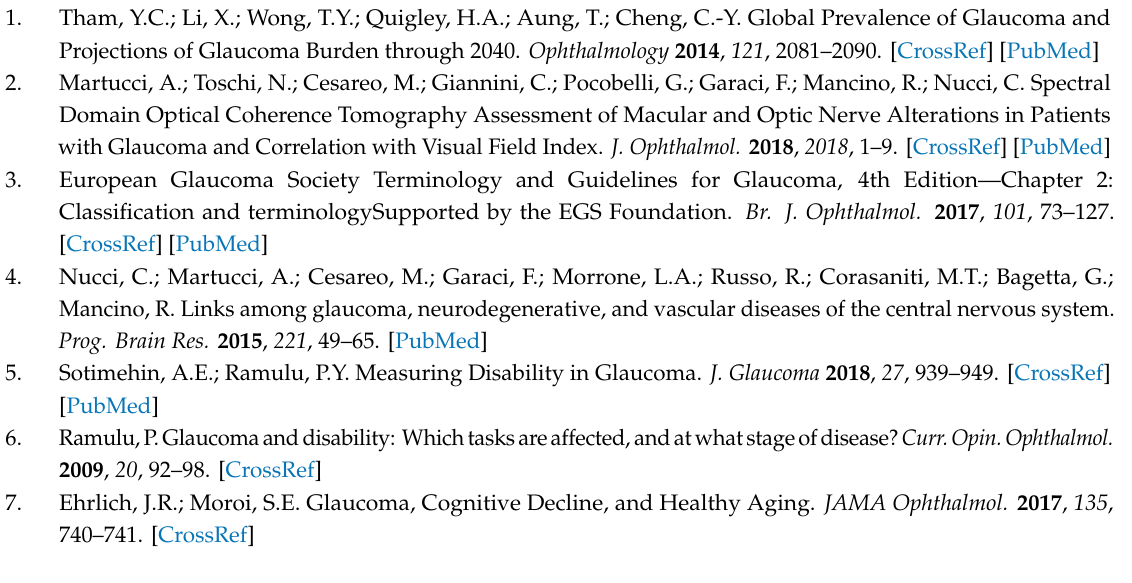
Table S1: Localization of brain regions which present statistically significant di ff erences in FA (CTRL > GLA). MNI: Montreal Neurological Institute, Table S2: Localizations of brain regions which present statistically significant di ff erences in KA (CTRL > GLA). MNI: Montreal Neurological Institute, Table S3: Localizations of brain regions which present statistically significant di ff erences in MK (CTRL > GLA). MNI: Montreal Neurological Institute, Table S4: Localizations of brain regions which present statistically significant di ff erences in RK (CTRL > GLA). MNI: Montreal Neurological